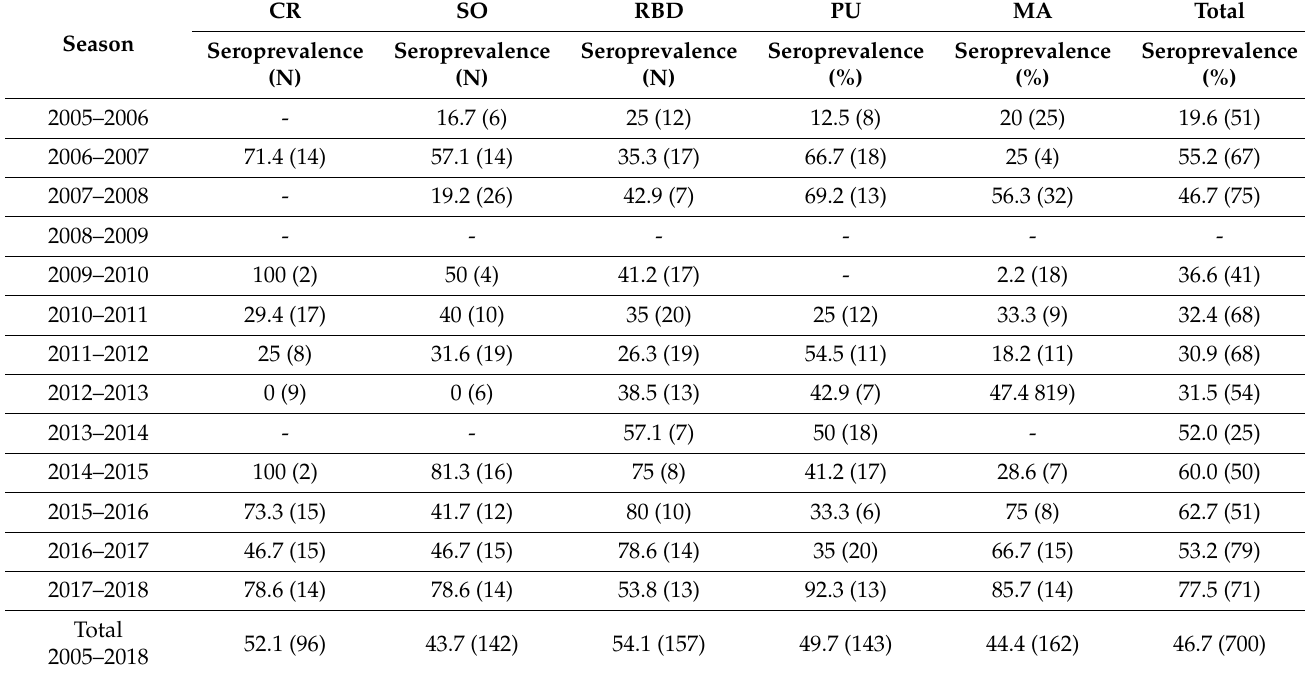
Table 1. Seropositivity for HEV (%) obtained by ELISA and sample size (N) by sampling period and livestock management area (Coto del Rey (CR), Sotos (SO), Doñana Biological Reserve (RBD), Puntal (PU) and Marismillas (MA)).